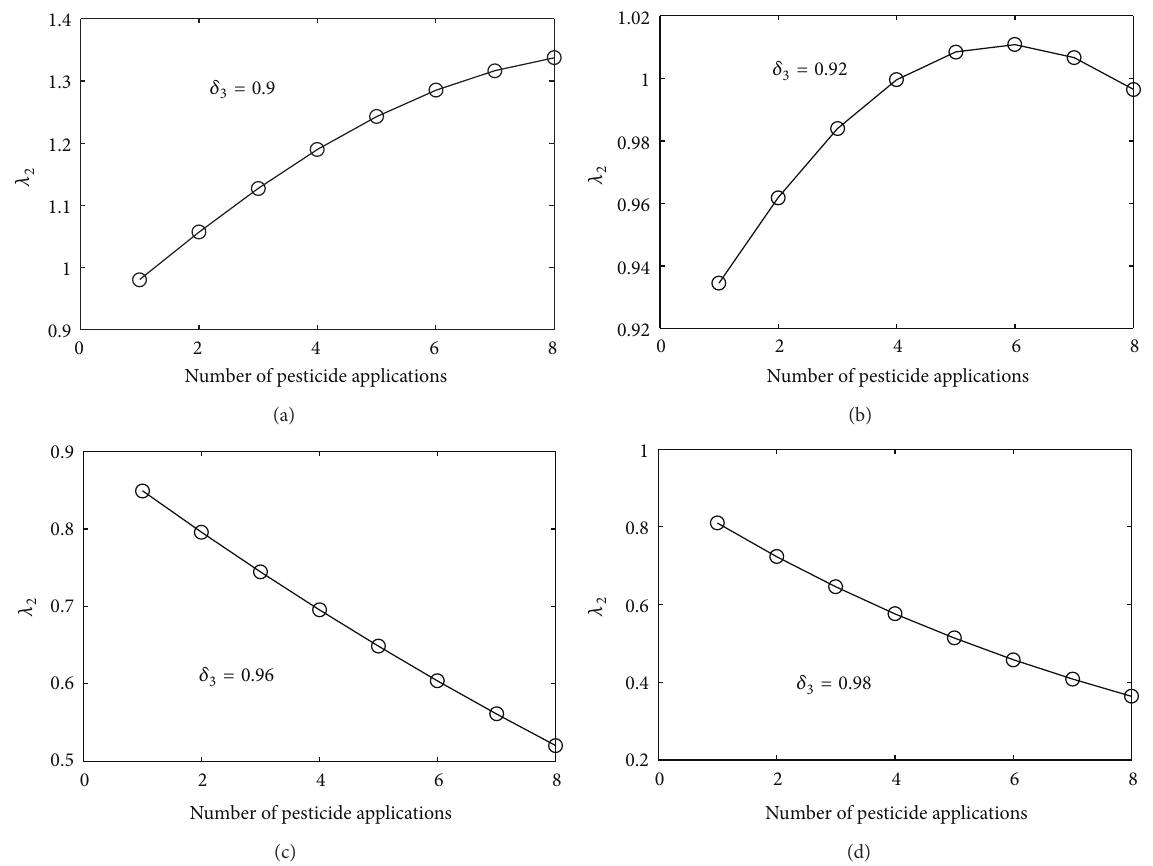
Figure 4: The effects of number of pesticide applications and the residual ratio of natural enemy on the threshold level 𝜆 2 . The parameter values are as follows: 𝛿 1 = 0.85 , 𝛿 2 = 0.85 , 𝑇 = 10.7 , 𝜃 = 6.3 , 𝑑 = 0.25 , 𝑟 = 1.2 , 𝑐 = 0.3 , 𝑎 1 = 0.75 , 𝑎 2 = 0.8 , and 𝛼 2 = 0.7